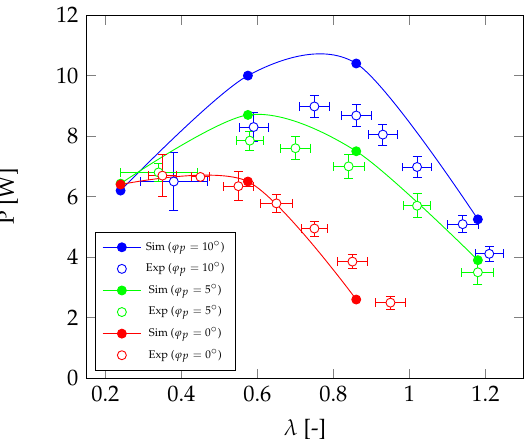
Figure 9. Comparison of performance between simulation and experiment depending on the tip speed ratio. The error bars represent the standard